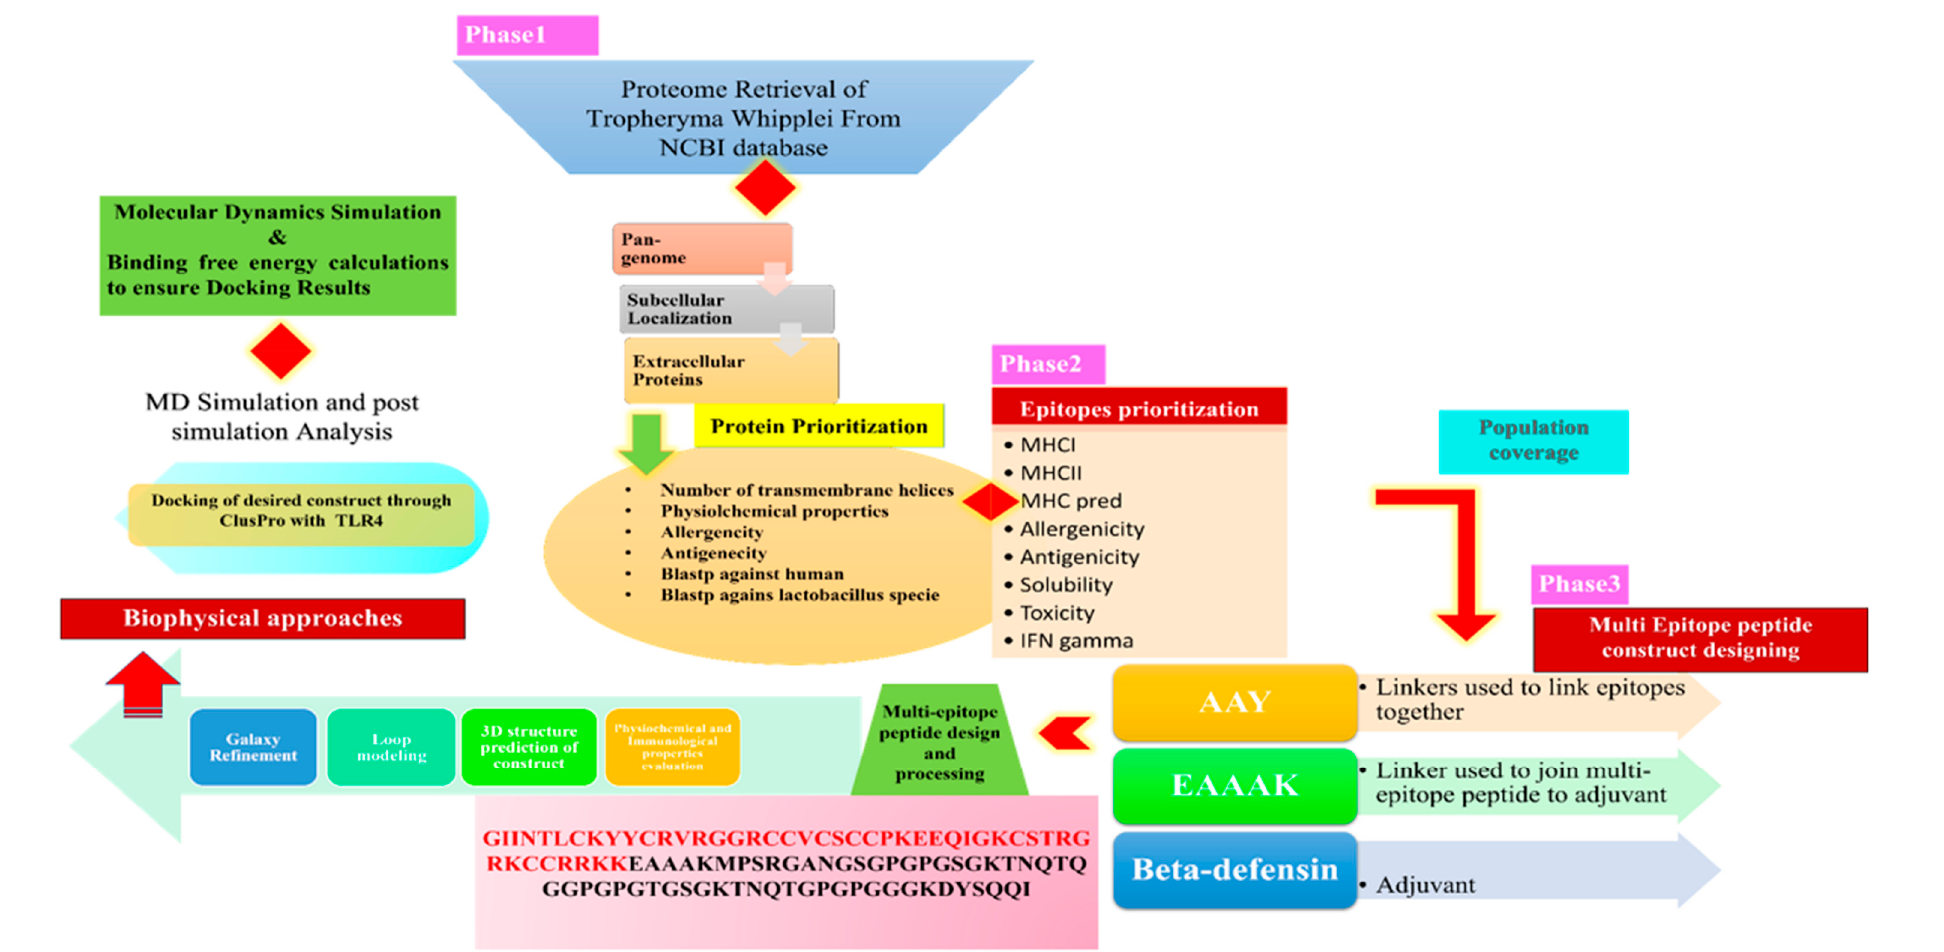
Figure 1. Schematic diagram highlighting all the steps in detail being used to proceed the study.